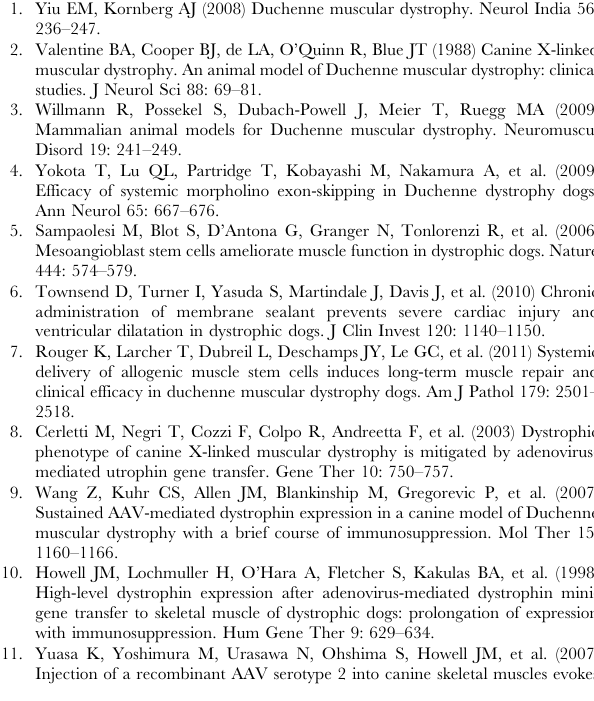
Figure S3 Illustration of the MHCs + positive fibers rarefaction treated dogs. MHCs immunostaining of a whole GRMD ctrl tibialis cranialis biopsy section (A) in comparison with the same immunostaining performed on a whole GRMD CsA + P tibialis cranialis biopsy section at 9 months (B). The loss of MHCs + fibers predominance in treated dogs is